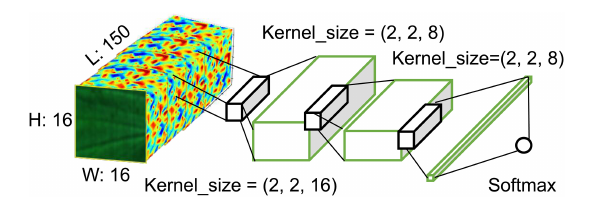
FIGURE 8 | Proposed 3D CNN structure of this